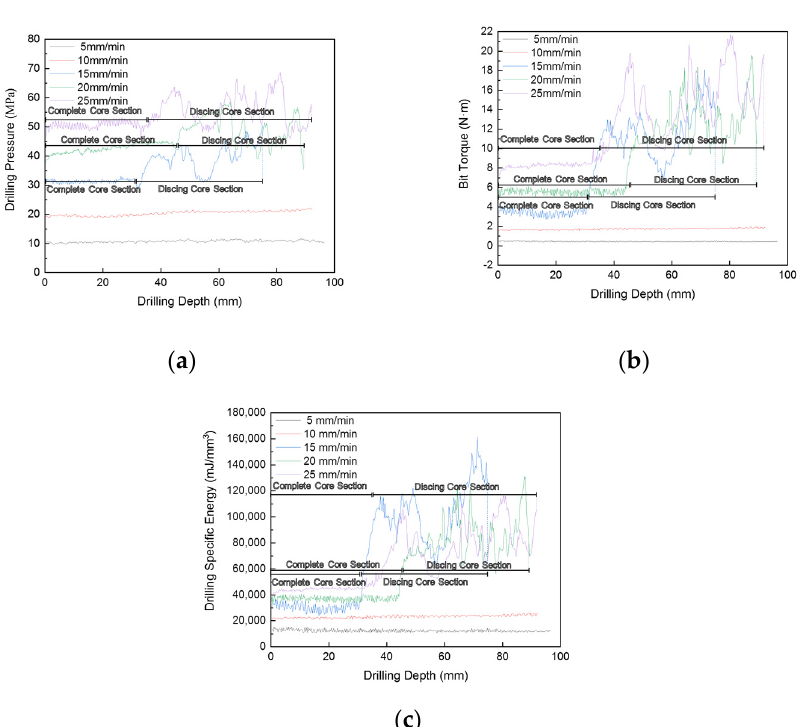
Figure 7. Monitored bit drilling pressure (a), torque (b), and specific energy (c) along complete granite core length at various drilling rates. ( a ) Drilling pressure; ( b ) Torque; ( c ) Specific energy. It is noted that the various features of drilling pressure, torque, and specific energy began at one-third (e.g., 30 mm) of core length when implementing high drilling rates (e.g., >15 mm/min.).